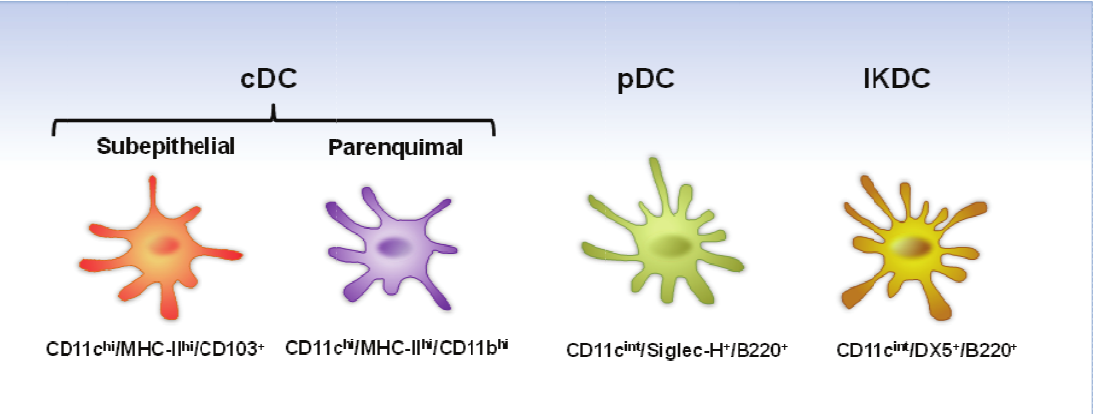
Figure 2. Mouse lu ung DC act tivated durin ng hRSV